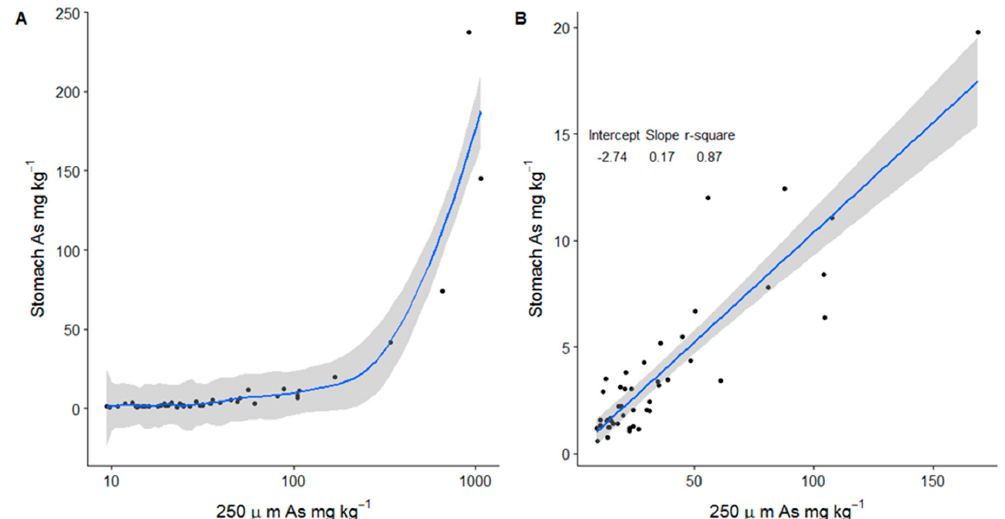
Figure 6. Relationship between total As in the <250 µm fraction and the bioaccessible stomach phase As. ( A ) full range of total As with Loess fit line, ( B ) total As <200 mg·kg − 1 with linear regression fit line. Grey region indicates standard error on the fit.